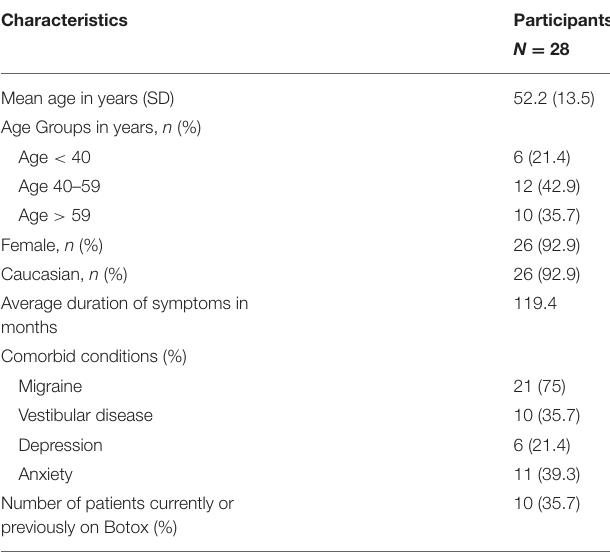
TABLE 2 | Demographic characteristics of the participants.